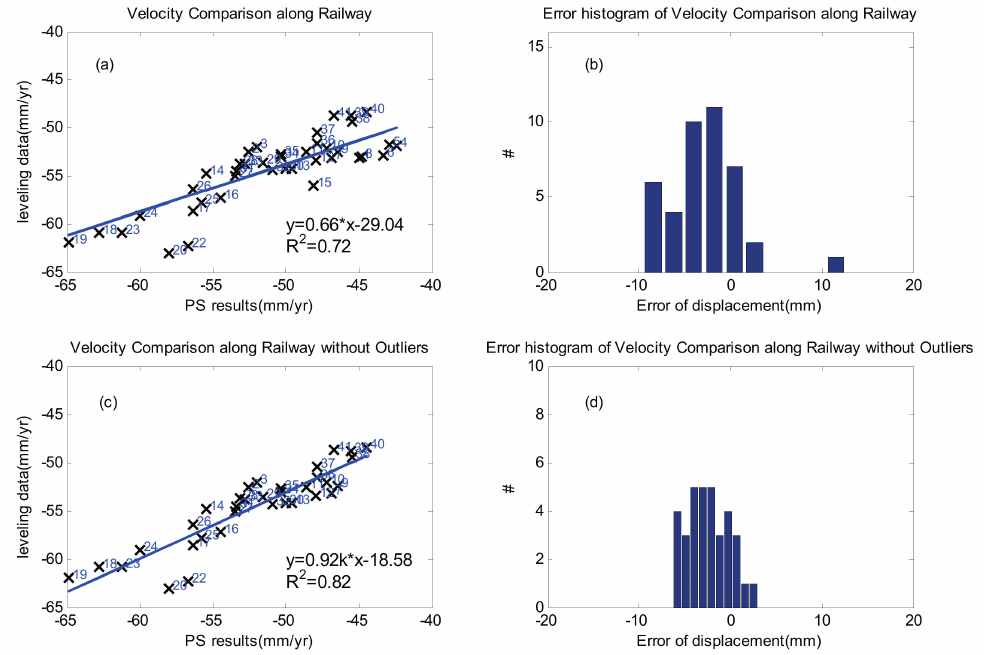
Figure 5. Regression analysis and error histogram of average subsidence velocity between PS results and leveling measurements along the railway. ( a ) Regression of average velocity by using the nearest neighbor method; ( b ) Error histogram of average subsidence velocity by using the nearest neighbor method; ( c ) Regression of average velocity by using the nearest neighbor method, without outliers; ( d ) Error histogram of average subsidence velocity by using the nearest neighbor method, without